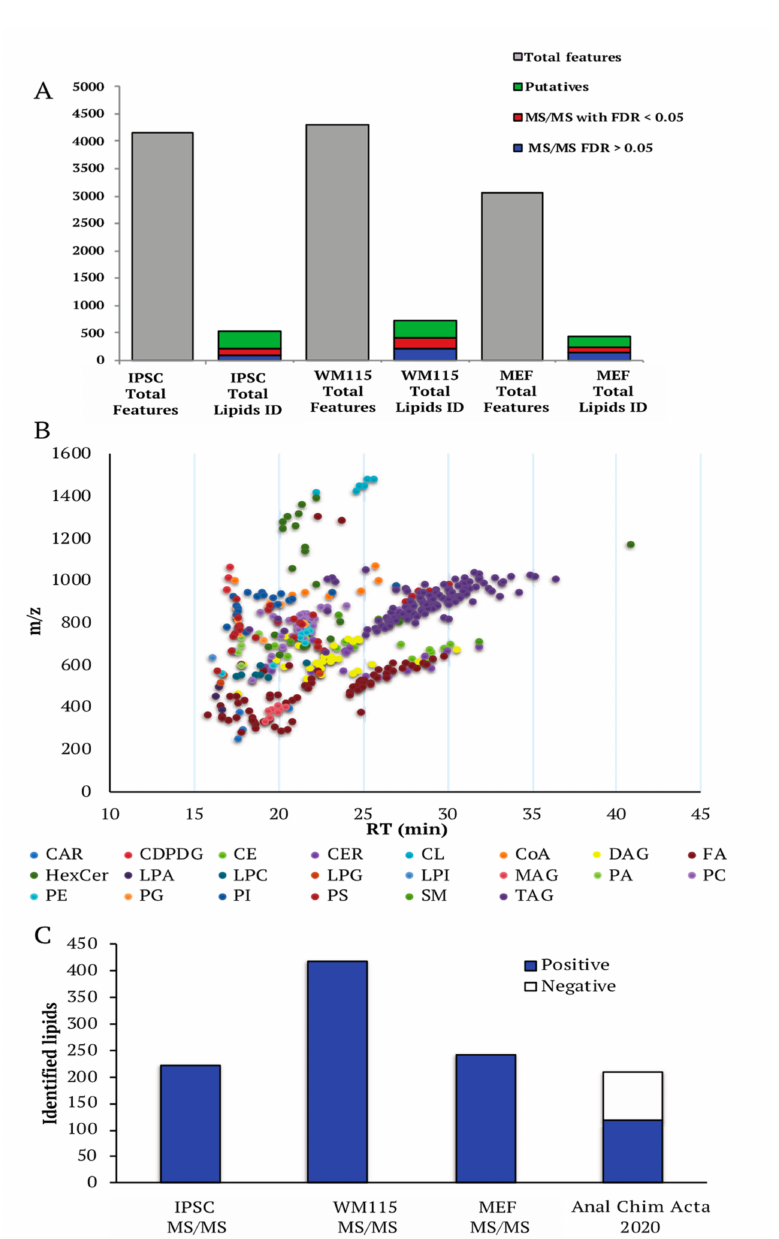
Figure 4. Untargeted lipidomics analysis by SMFinder. ( A ) Number of features and total lipids identified by exact mass and MS/MS match with or without FDR filter in all three datasets: MEF, IPSC, and WM115 cell lines. ( B ) Lipid classes distribution of all lipids identified by SMFinder along the gradient in dependence of m/z . ( C ) Comparison of lipids identified by MS/MS match in this study and in a recently published work using nanoflow-based lipidomics